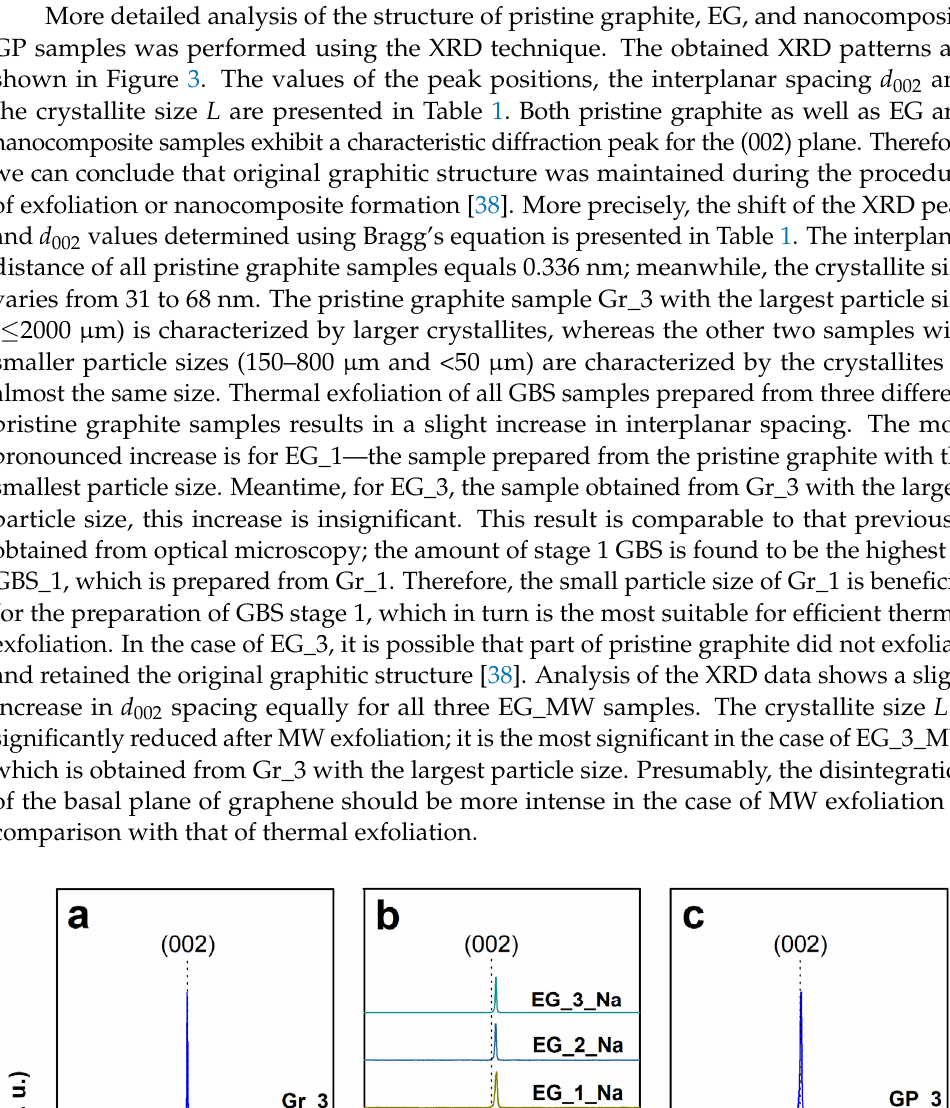
Figure 2. SEM micrographs of precursor graphite of different grain sizes, EG and GP products: Gr_1